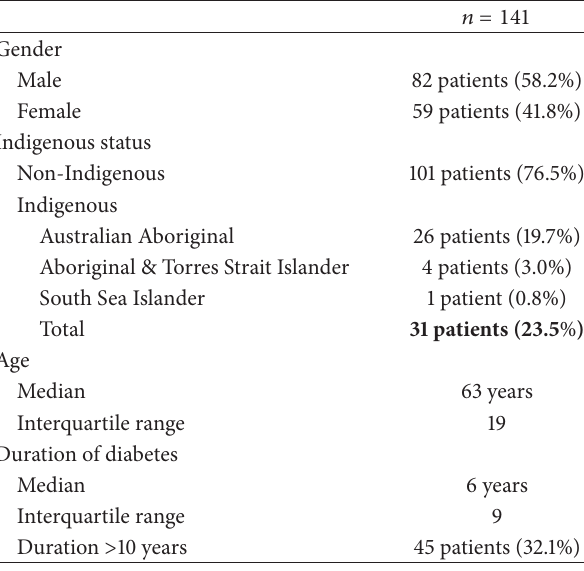
Table 2: Participant demographics.